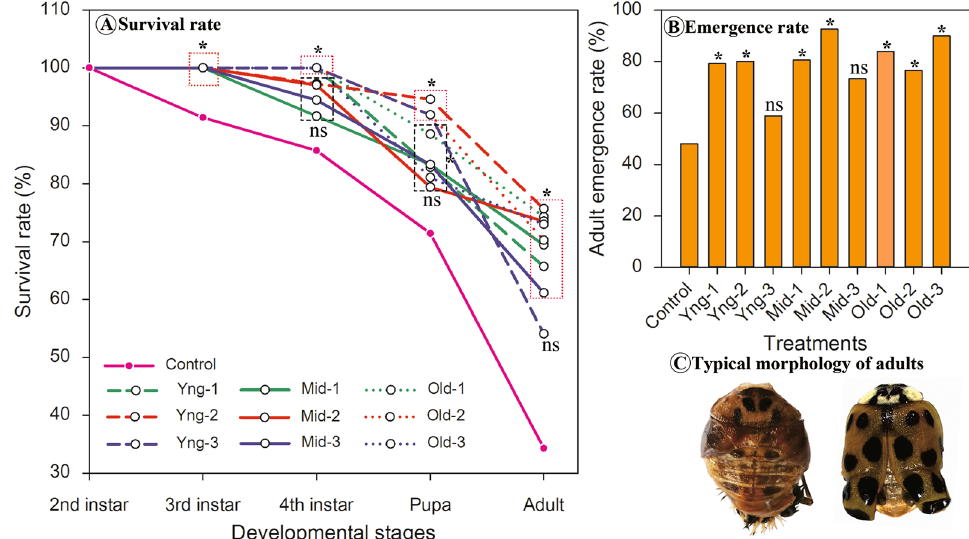
Fig. 2 Performance of Harmonia axyridis cannibals when feeding on artificial diets. Stage‑specific survivals ( A ) and the pupa‑adult emergence rates ( B ). Here, the typical morphology of unsuccessfully emerged pupa (left) and the malformed newly emerged adults (right) was highlighted ( C ). Asterisk indicates a significant difference between the egg cannibal beetles and the control beetles at each stage ( p < 0.05), while ns means non‑significant difference ( p > 0.05). For stage‑specific survivals ( A ), those treatments in the same box with dotted line had similar variation trends as compared to the control treatment, and they were labelled with shared